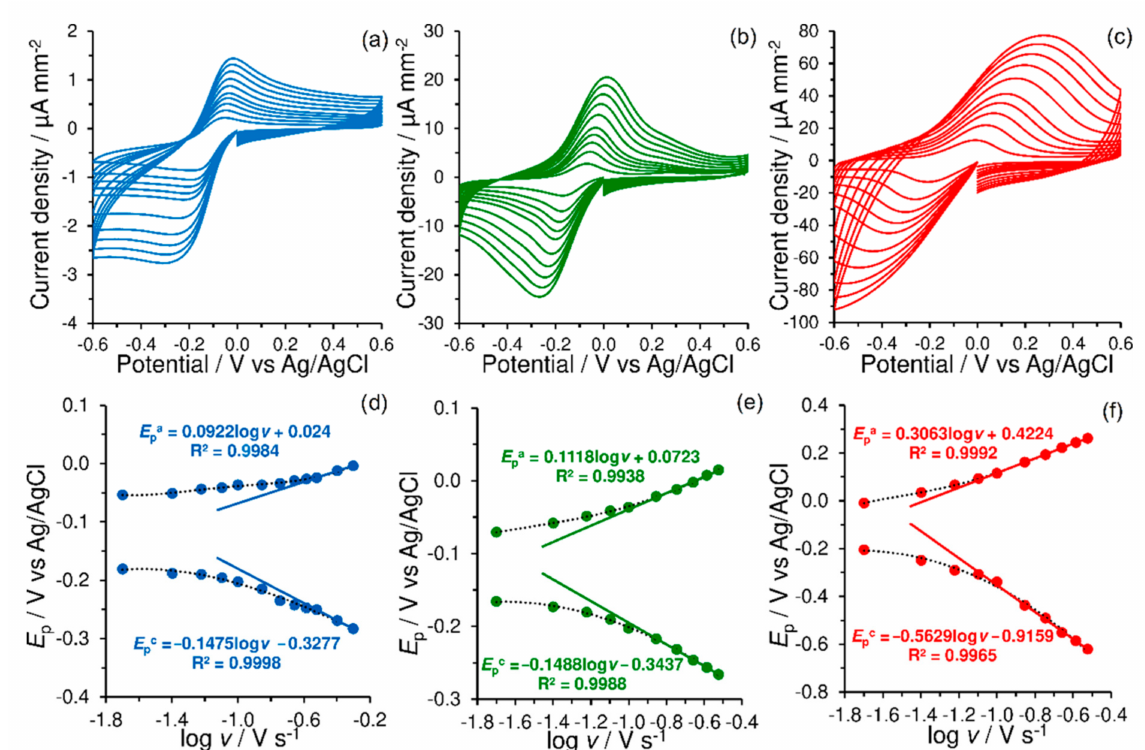
Figure 3. Cyclic voltammograms of 0.1 mol L − 1 PB (pH 7.5) at GCE/CBCC-Nafion ® ( a ), GCE/MWCNTs/CBCC-Nafion ® ( b ), and GCE/rGO/CBCC-Nafion ® ( c ) obtained at scan rate of 20, 40, 60, 80, 100, 140, 180, 220, 260, and 300 mV s − 1 with the corresponding trumpet plots ( d – f